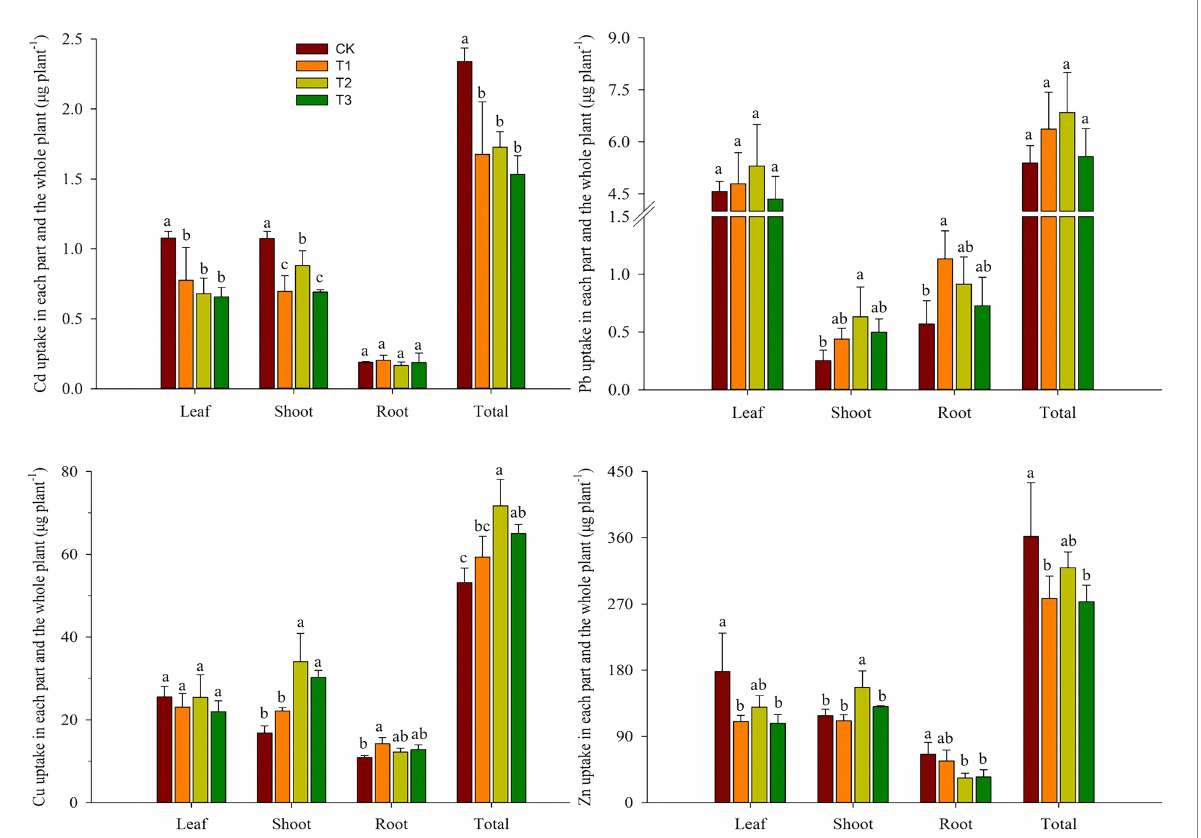
FIGURE 4 Effects of compost application on heavy metal uptake in each component as well as the entire plant (mean ± SD, n = 3). CK, T1, T2, and T3 are compost application at rates of 0, 15, 30, and 45 t ha − 1 , respectively. The different lowercase letters indicate significant differences ( p < 0.05) between